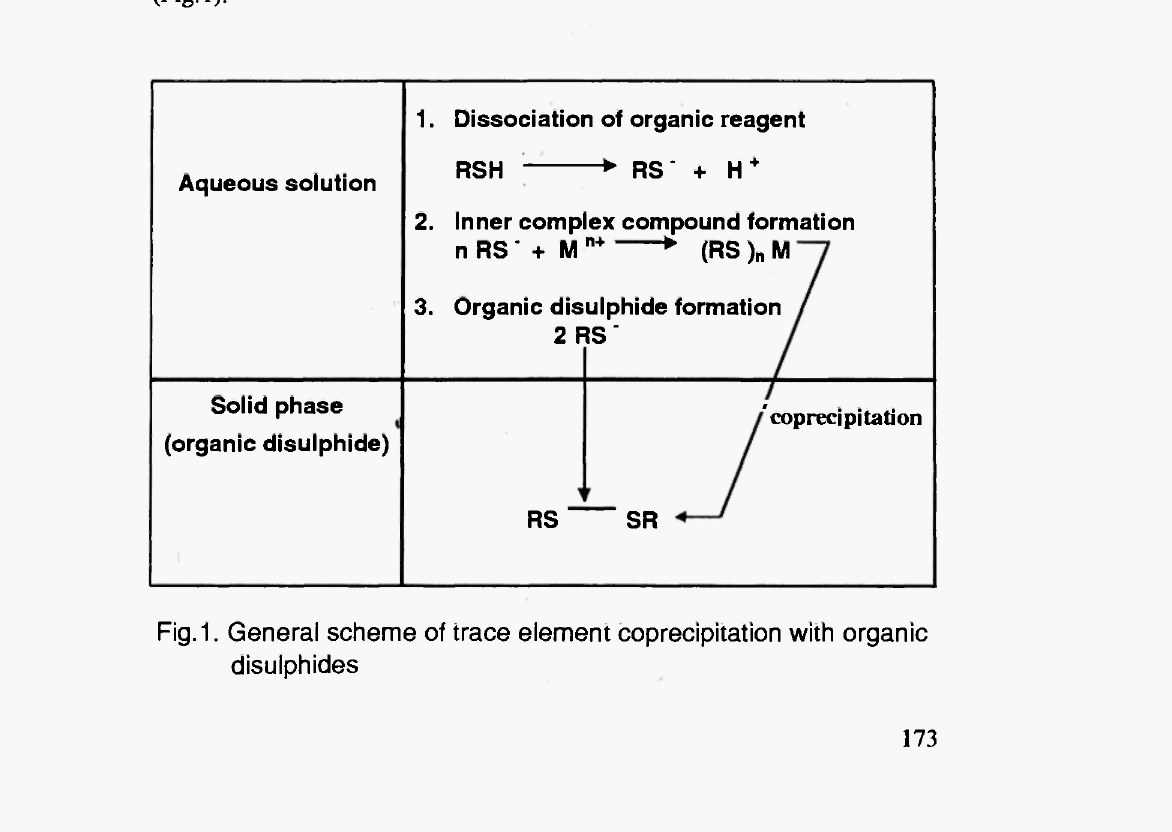
Fig. 1. General scheme of trace element coprecipitation with organic